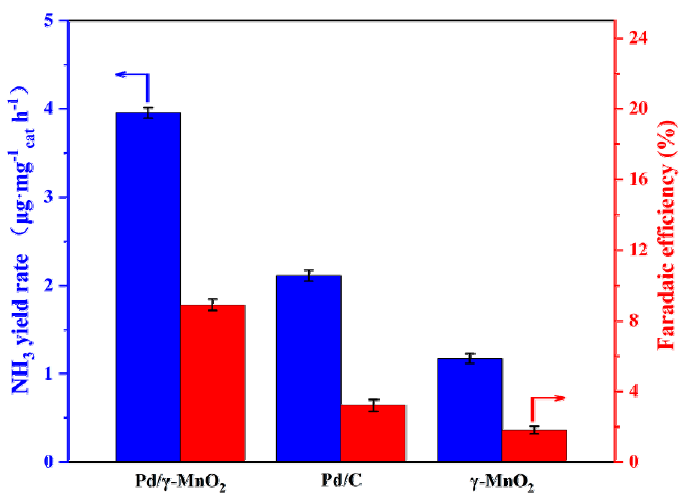
Figure 5. Comparison of the Pd/ γ -MnO 2 catalyst with Pd/C and γ -MnO 2 catalysts for catalytic performance at -0.05 V in 0.1 M KOH.